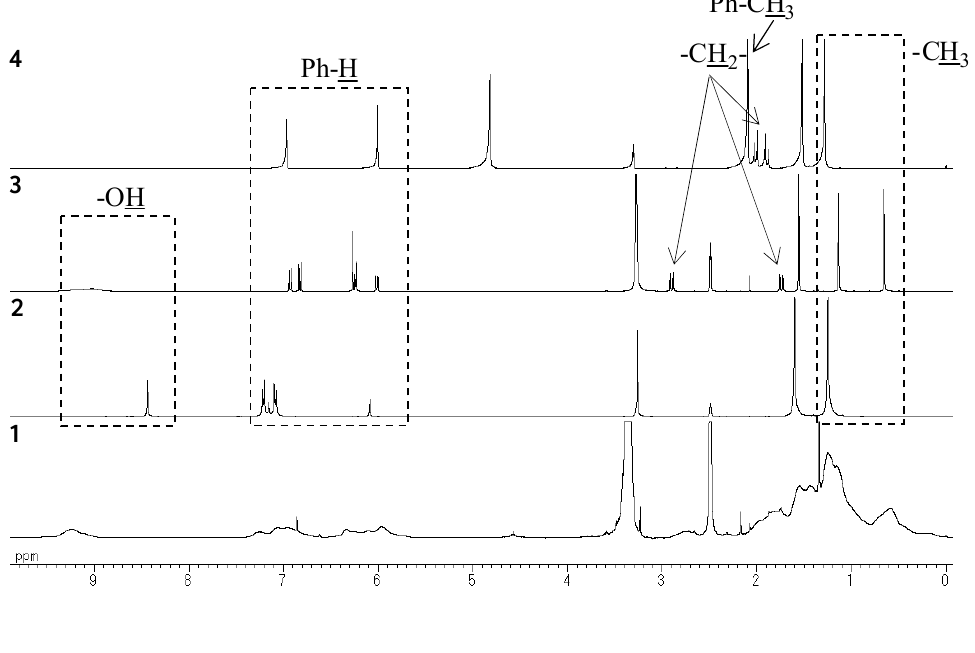
Figure 2 . 1 H-NMR spectra of 1 , 2 , 3 (DMSO, 400 MHz), and 4 (MeOH, 400 MHz).